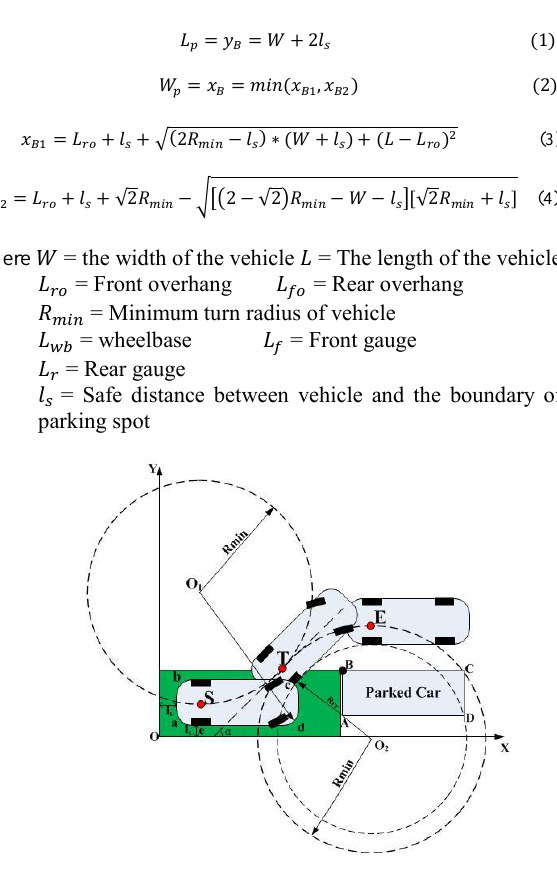
Figure 2. Minimum size of parallel